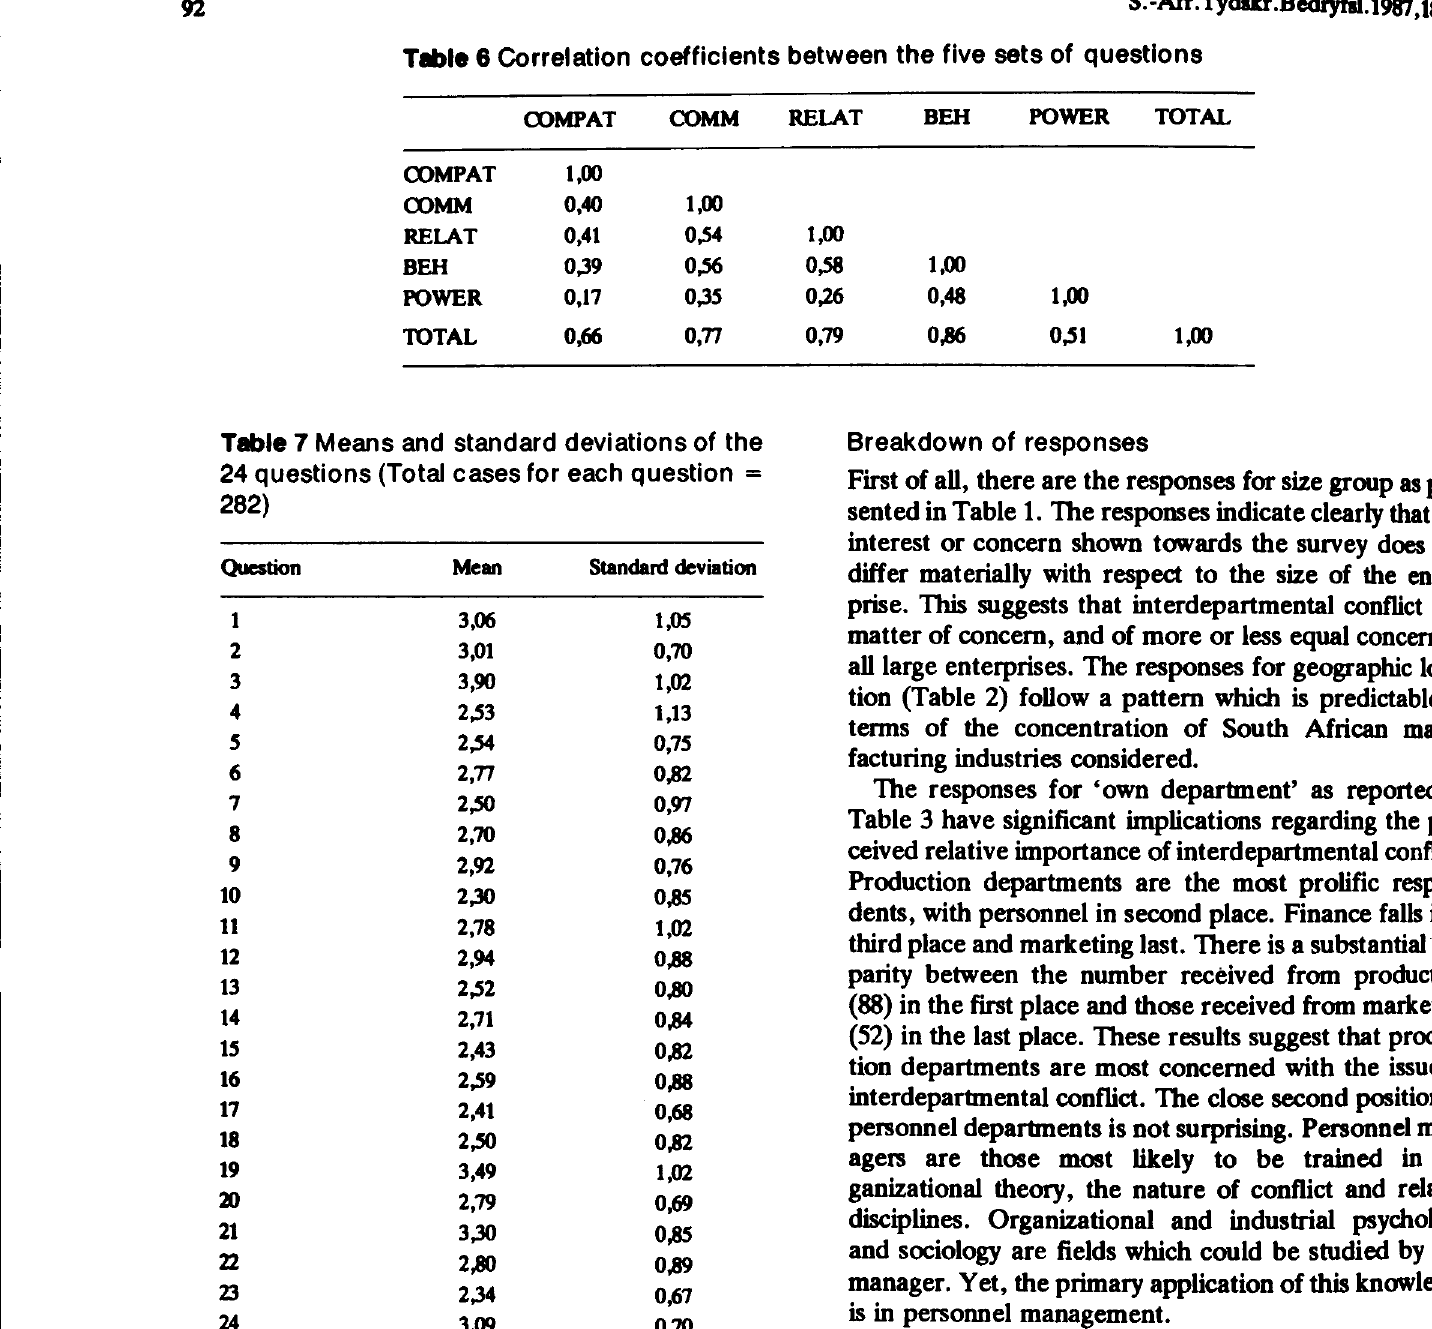
Table 6 Correlation coefficients between the five sets of questions COMPAT BEH